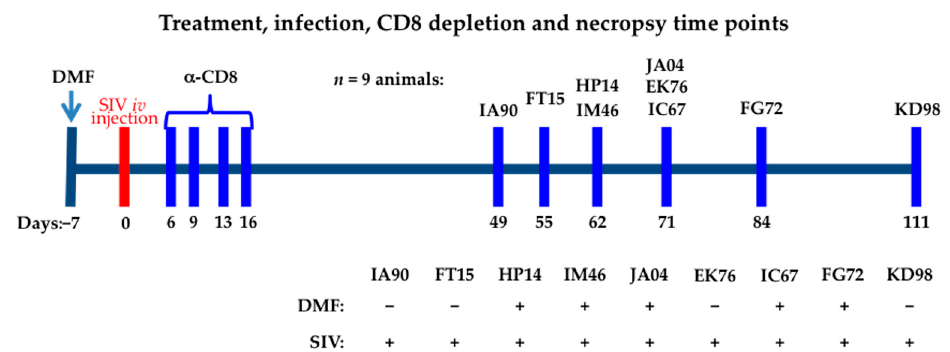
Figure 1. Schedule for dimethyl fumarate (DMF) treatment, anti-CD8 antibody treatments, simian immunodeficiency virus (SIV) inoculation, and necropsies of rhesus macaques. DMF treatment (90 mg total DMF daily, 5 animals DMF-treated, 4 untreated) was initiated seven days prior to the SIV infection, which was considered to be day “0”. On day “0” all animals (9 rhesus macaques) were intravenously infected with 100 TCID 50 (50% tissue culture infectious dose) SIV mac251 . CD8 + T lymphocyte depletion was achieved via treatment with anti-CD8 antibody infusions from 6 to 16 days post infection (dpi) via subcutaneous administration (10 mg/kg for the first dose and then subsequent doses at 5 mg/kg. Necropsies were performed at the indicated dpi thereafter. Individual animals are identified by unique letter–number combinations.